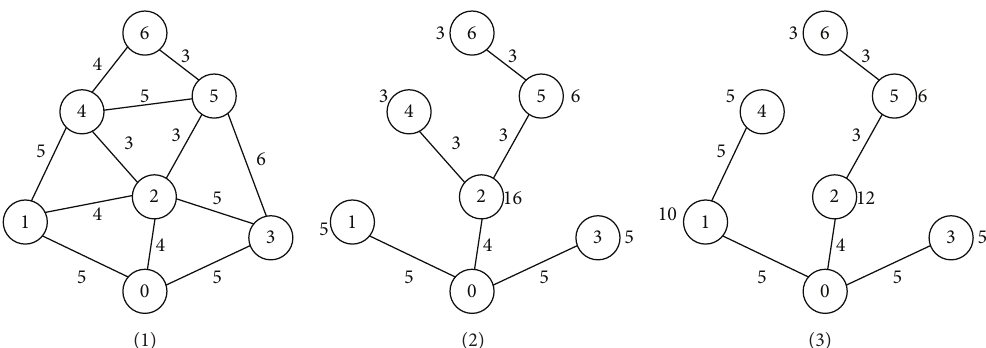
Figure 1: A small network in which node 0 is the sink. (1) The network’s topology, (2) the LET, and (3) the routing tree with smaller maximal load than LET [11].